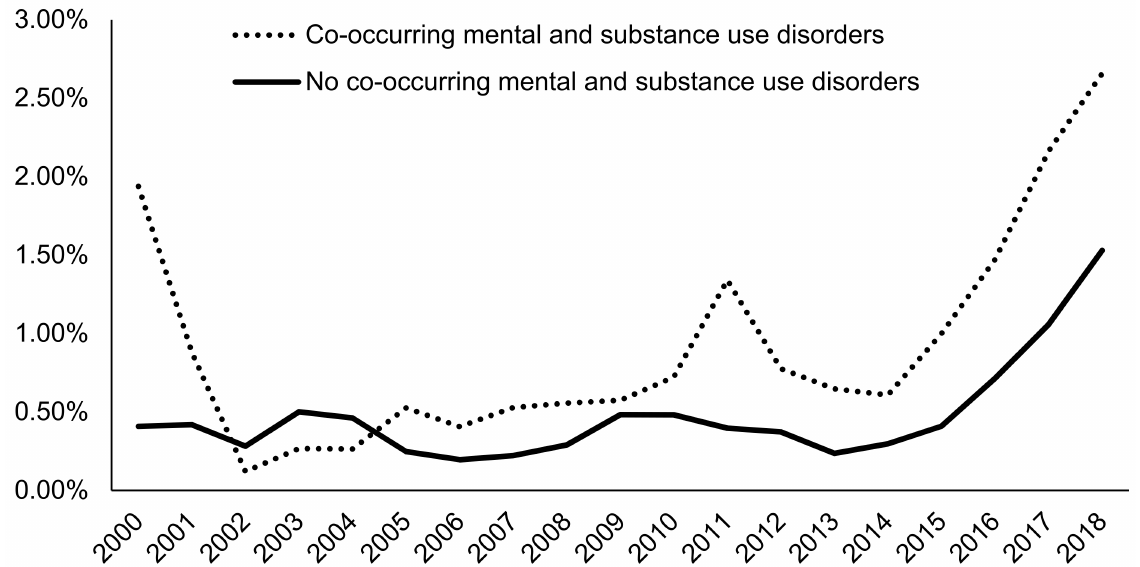
Figure 7. Prevalence of naltrexone treatment prescribed in alcohol use disorder (AUD) admissions from 2000–2018 by status of co-occurring mental disorders using TEDS-A data. Temporal trends were significant by the Cochran–Armitage trend test ( p < 0.0001).